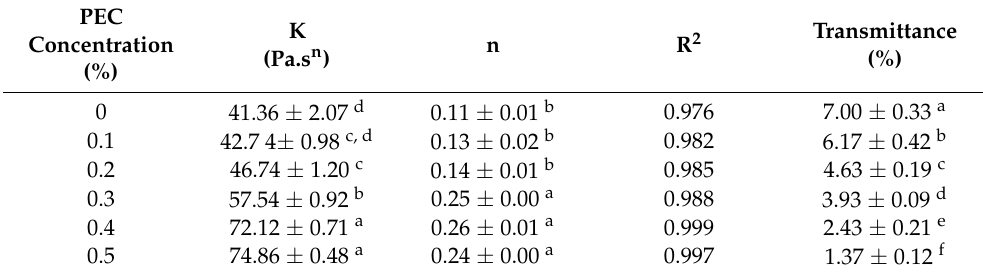
Table 3. Power-law parameters and transmittance of WRS pastes with different pectin contents